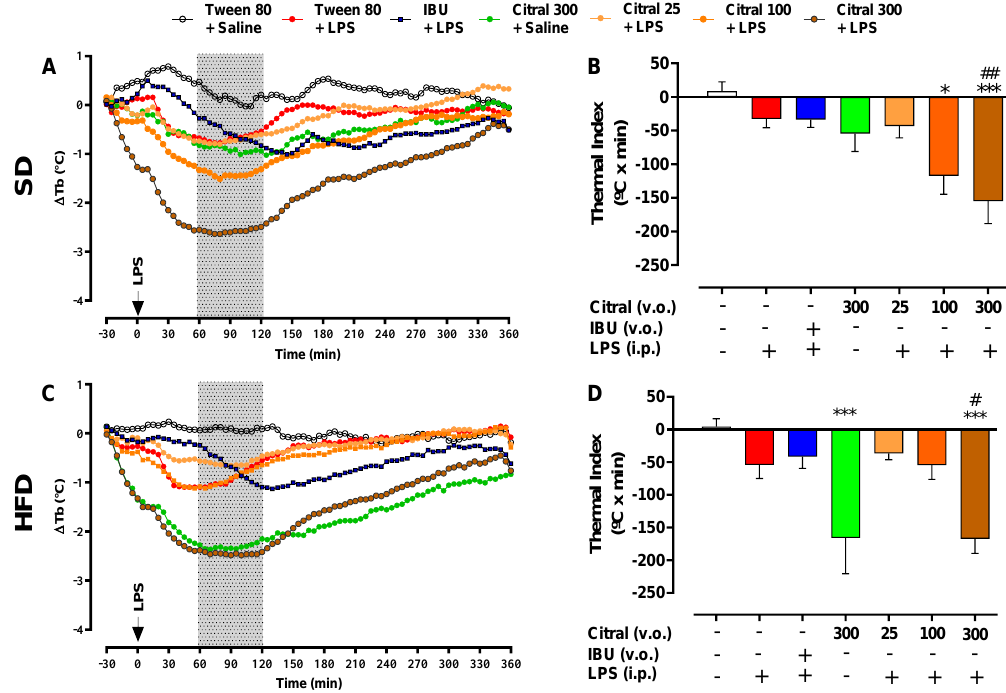
Figure 1. E ff ect of citral (25, 100, and 300 mg / kg) and IBU (100 mg / kg) oral treatment (p.o.) on body temperature variation ( ∆ Tb) profile of mice fed standard diet (SD) and high-fat diet (HFD) after LPS-induced Systemic Inflammation (SI). Tb profile of eutrophic ( A ) and obese ( C ) mice was observed for 360 min after intraperitoneal (i.p.) administration of LPS (100 µ g / kg) or saline (1 mL / kg). The hatched area represents the period used for calculating the thermal index of SD ( B ) and HFD ( D ) during 60–120 min of SI. The results are presented as mean ± SEM for n = 7–9 per group. One-way ANOVA followed by Tukey’s test; * p < 0.05 and *** p < 0.001 vs. Tween 80 + saline; # p < 0.05 and ## p < 0.01 vs. Tween 80 +